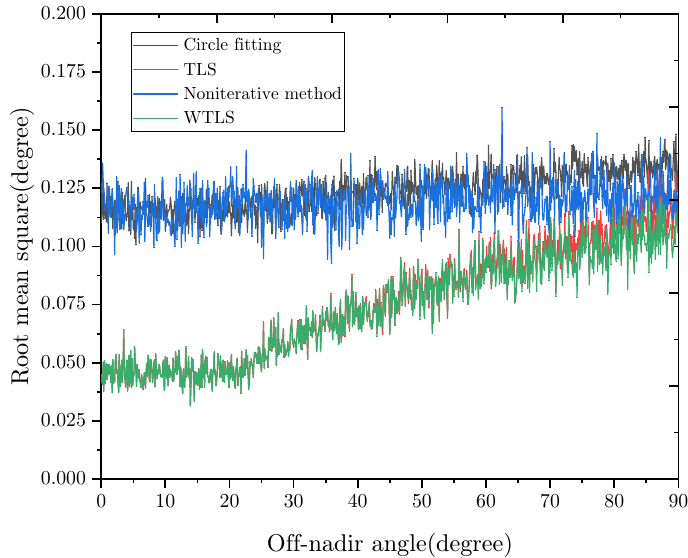
Figure 7. RMS error of the nadir vector vs. off-nadir angle. Off-nadir angle = 0–90 ◦ .